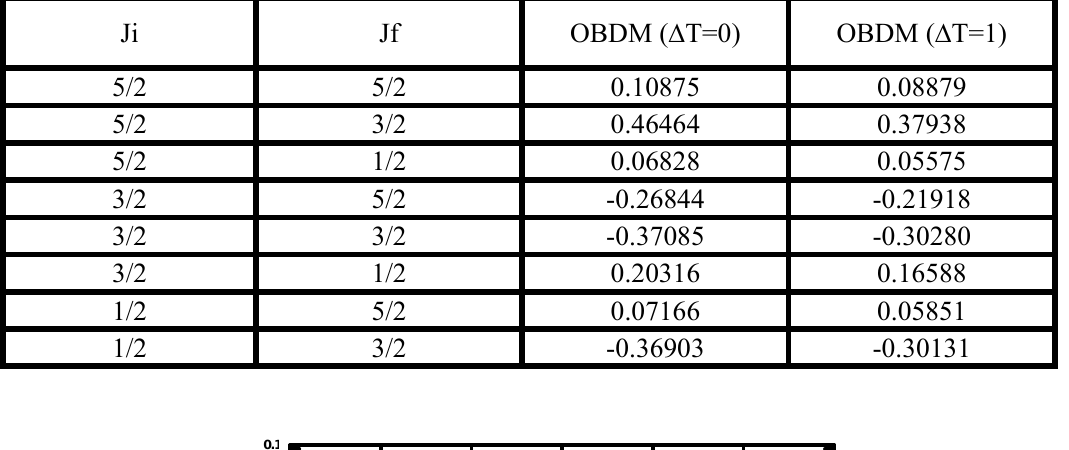
Table 4: The values of the OBDM elements for the longitudinal C2 transition of the 2 1, third 2 state of 58Ni using F5PVH model space effective interaction., with M3Y and Gogny as a residual interaction at E =3.250 MeV. X